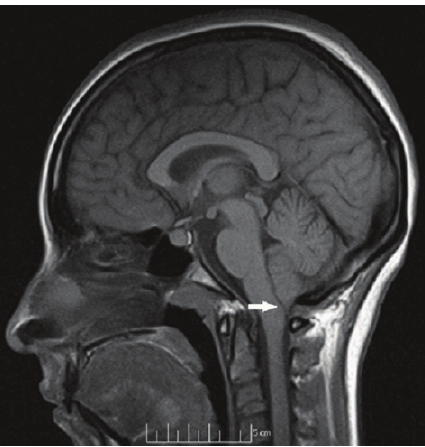
Figure 1: Sagittal magnetic resonance image of Arnold-Chiari type I malformation. White arrow denotes the 7mm tonsillar herniation from the cerebellum. No syringomyelia is